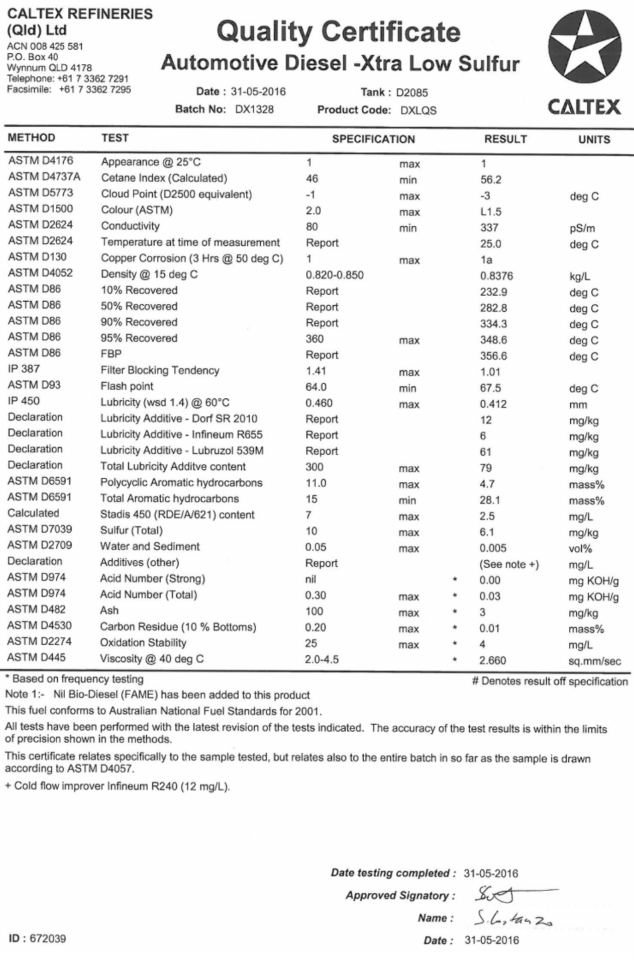
Figure A1. Quality certificate of